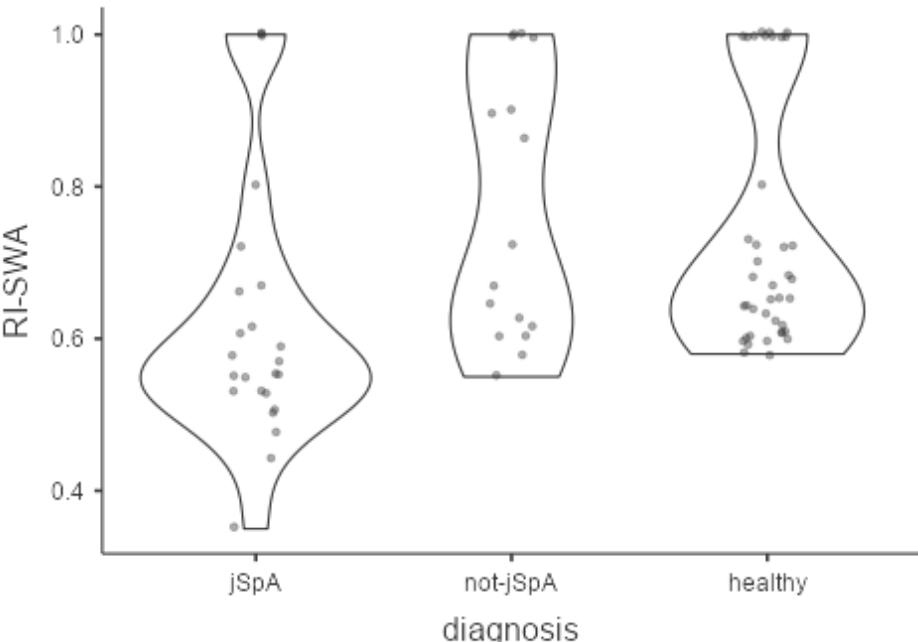
Figure 3. Comparisons of RI-SWA among the groups expressed as violin plots. The Kruskal–Wallis test showed significantly differences in RI values among groups ( p < 0.001). The pairwise comparisons demonstrated lower RIs in jSpA respect both to not-jSpA patients ( p = 0.005) and healthy subjects ( p = 0.001), but not significant difference between not-jSpA patients and healthy subjects ( p = 0.969).